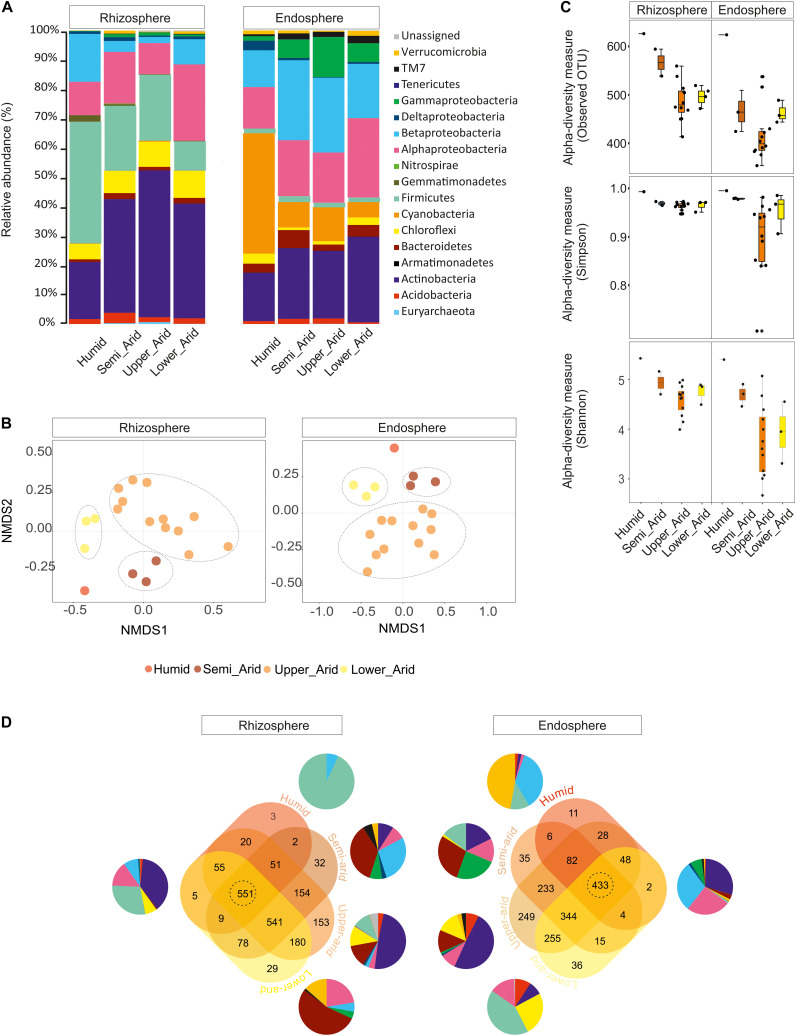
Relative abundance of rhizosphere and endosphere prokaryotic communities of Opuntia ficus-indica across the different bioclimatic zones (humid, semi-arid, upper-arid, lower-arid). (A) Relative phylogenetic abundance based on frequencies of 16S rRNA gene sequences affiliated with archaea and major bacterial phyla or proteobacterial classes. (B) Non-metric multidimensional scaling (NMDS) plots for Bray–Curtis distances of the prokaryotic communities associated with Opuntia ficus-indica across bioclimatic zones in the rhizosphere (stress value = 0.122, PERMANOVA, P < 0.001) and endosphere (stress value = 0.093, PERMANOVA, P < 0.03). (C) Prokaryotic alpha diversity indices (Simpson: p-value: 0.0024; ANOVA test: F-value: 4.24; Shannon: p-value: 1.9713 10–05, ANOVA test: F-value: 8.0451) and richness (observed OUT) (p-value: 3.13 10–06, ANOVA test: F-value: 9.83) in the rhizosphere and endosphere from each bioclimatic zone. (D) Venn diagrams showing the distribution of prokaryotic measurable OTUs associated with Opuntia ficus-indica in the rhizosphere and endosphere from each bioclimatic zone and shared OTUs as described for (A). Samples from the humid, semi-arid, upper-arid, and lower-arid bioclimatic zones shared a high-degree overlap (551 and 433 OTUs) in the rhizosphere and endosphere, respectively. Specific number of OTUs for each bioclimatic zone and their taxonomic affiliation were changed across the aridity gradient. The higher numbers of OTUs (153 and 249 OTUs) were observed in the upper-arid bioclimatic zone in rhizosphere and endosphere samples, respectively.